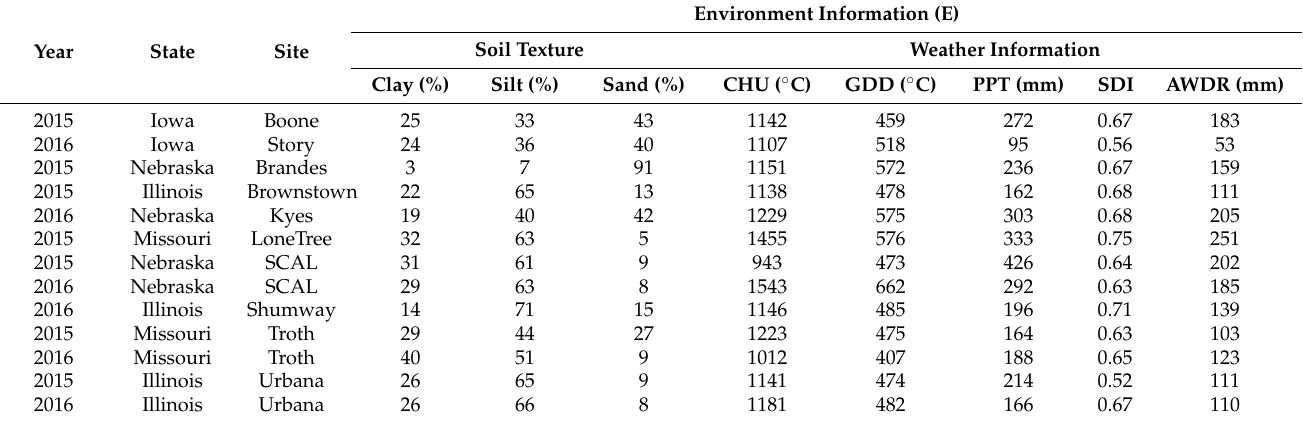
Table 3. The description of soil texture and weather variables for each site-year used in this